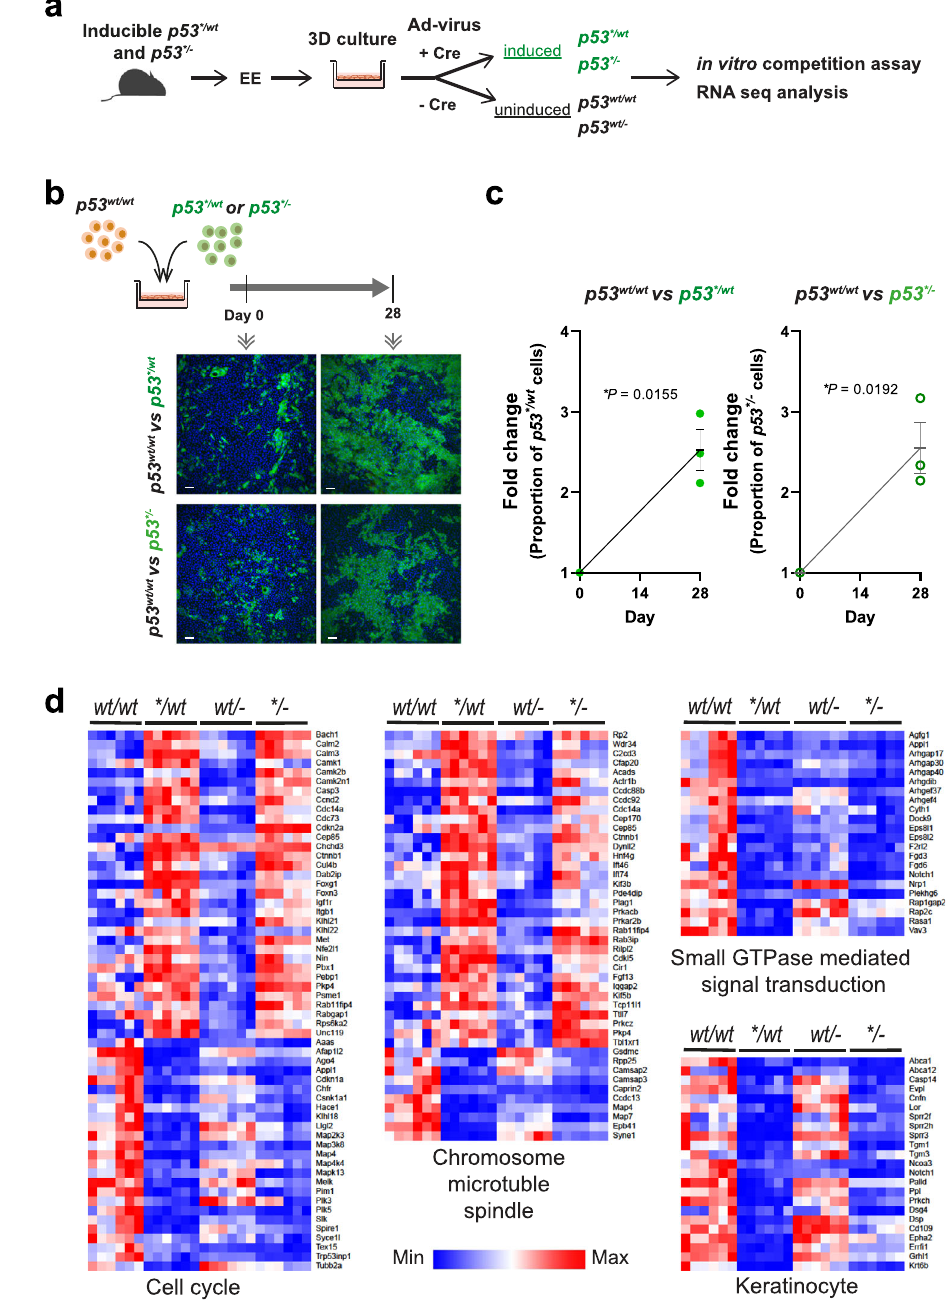
Fig. 3 | Effect of loss of heterozygosity (LOH) on mutant cell behaviour. a A 3D primary culture system was used to characterize p53 mutant cells in vitro. Oeso- phageal keratinocytes were isolated from transgenic mice and p53* mutation was induced by adenovirus carrying cre recombinase. b Cell competition assay. p53 */wt and p53 */ − cells were co-cultured with p53 wt/wt cells respectively and relative fi tness was examined. Representative immuno fl uorescence images from three biological replicates at day 0 and 28 are shown. Green, GFP; blue, DAPI. Scale bars, 50 µ m. c Quantitation of cell competition assay by fl ow cytometry. Graph shows the fold changeofproportionofGFP+ p53 */wt or p53 */ − cellintheculture.Blacklinesindicate